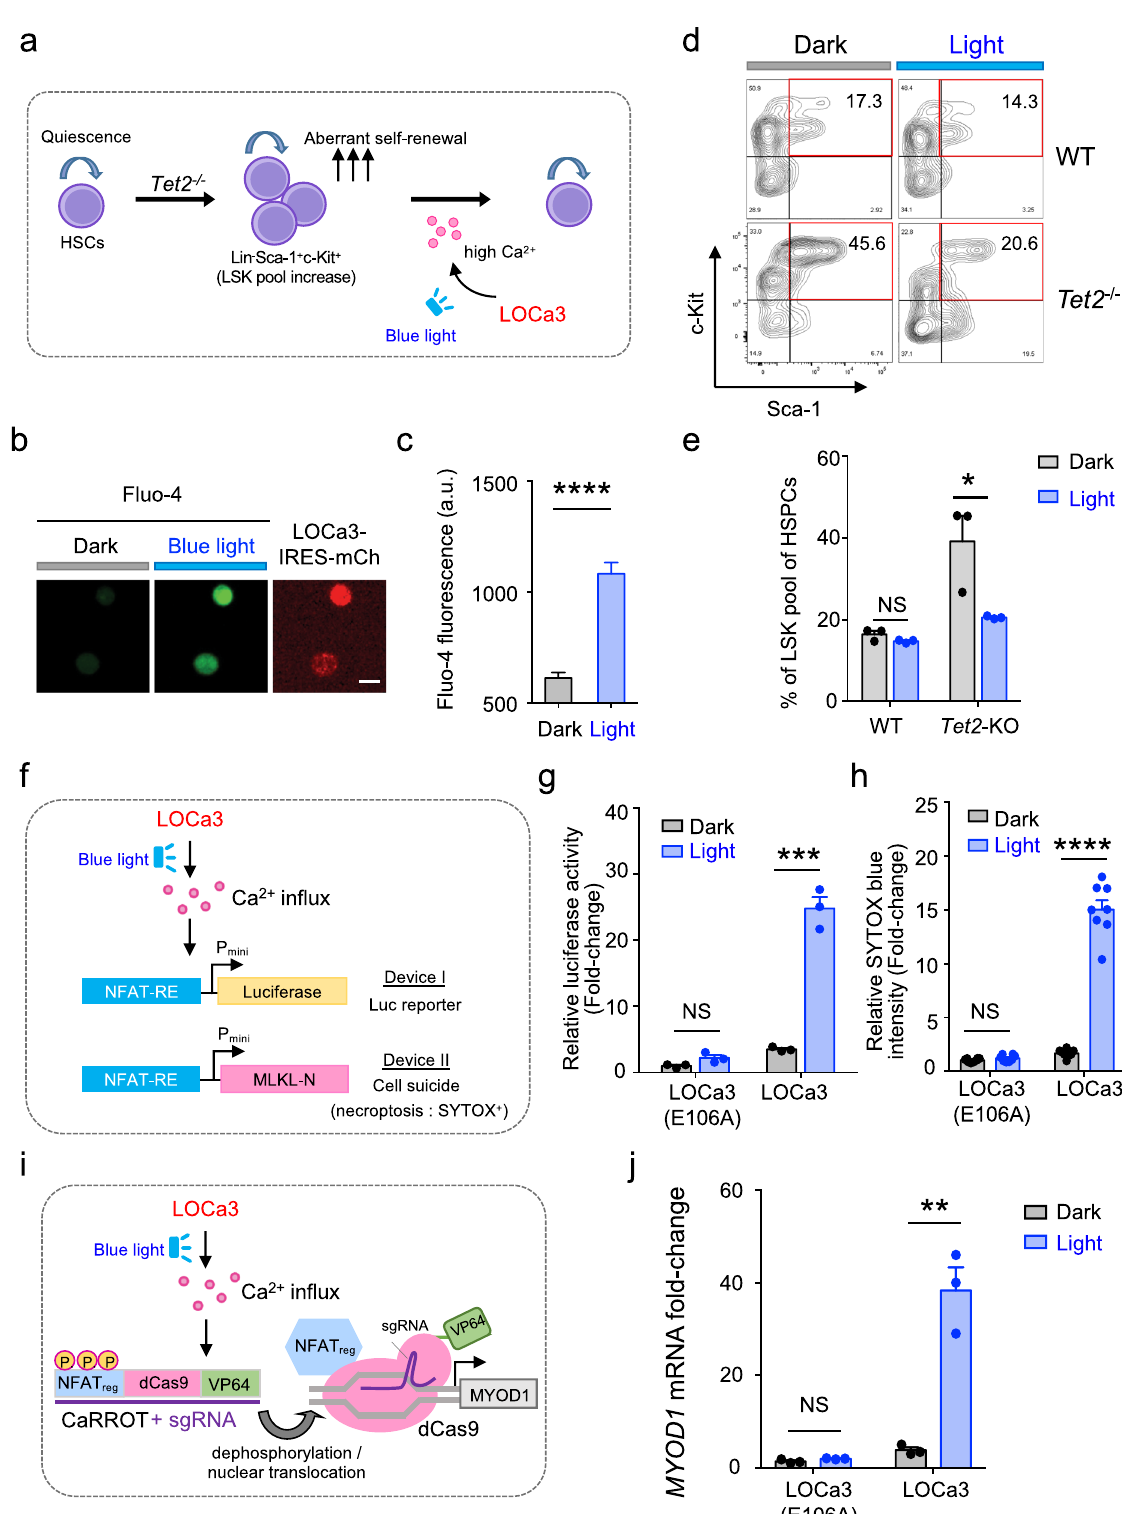
neurodegenerative phenotype. For transgenic fl ies subjected to blue light illumination (pulsed LED at 470 nm with a density of 40 µW/ mm 2 ; 10 min for each hour per day), aged fl ies showed a signi fi cant improvement in their climbing ability (blue vs black traces; right panel, Fig. 4d and Supplementary Movie 4). Taken together, we have demonstrated the feasibility of optogenetic modulation of Ca 2 + signals to intervene in neurodegeneration in vivo.